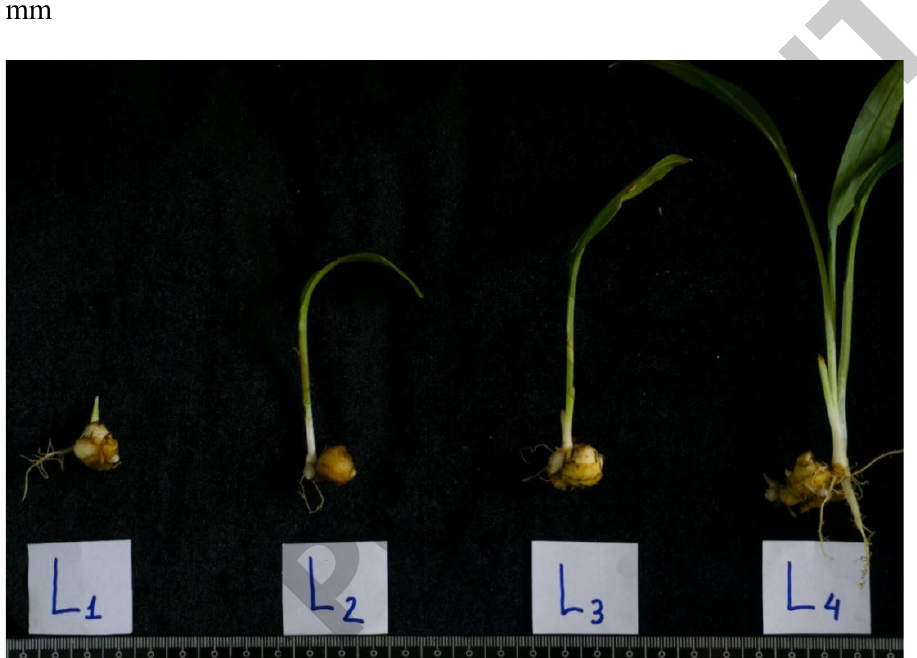
Figure 6. Shoot heights of different microrhizome sizes (L1, L2, L3, L4) after two months of ex vitro